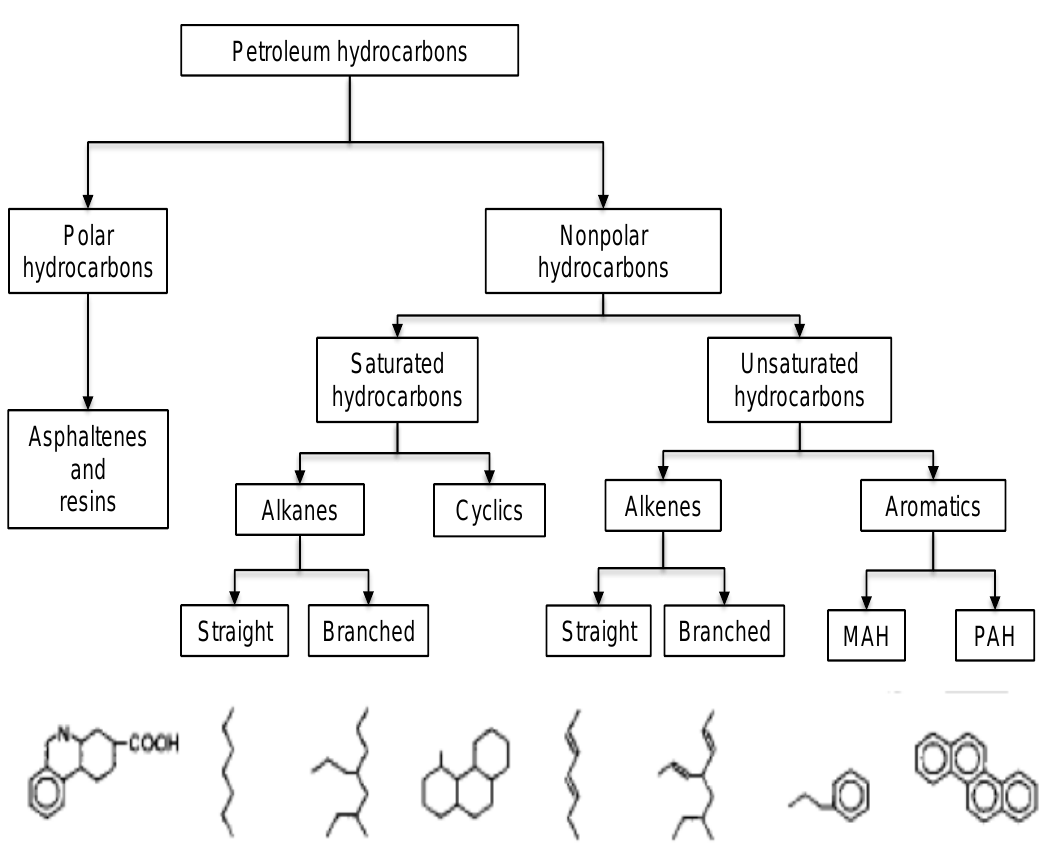
Figure 1. Chemical classification of petroleum hydrocarbons. (MAH = Monoaromatic hydrocarbons; PAH = Polycyclic aromatic hydrocarbons). Source: Coulon and Wu [26].